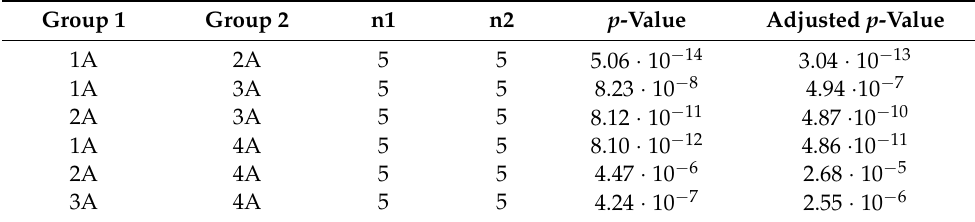
Table 11. Results of Student’s t -test with Bonferroni adjustment.